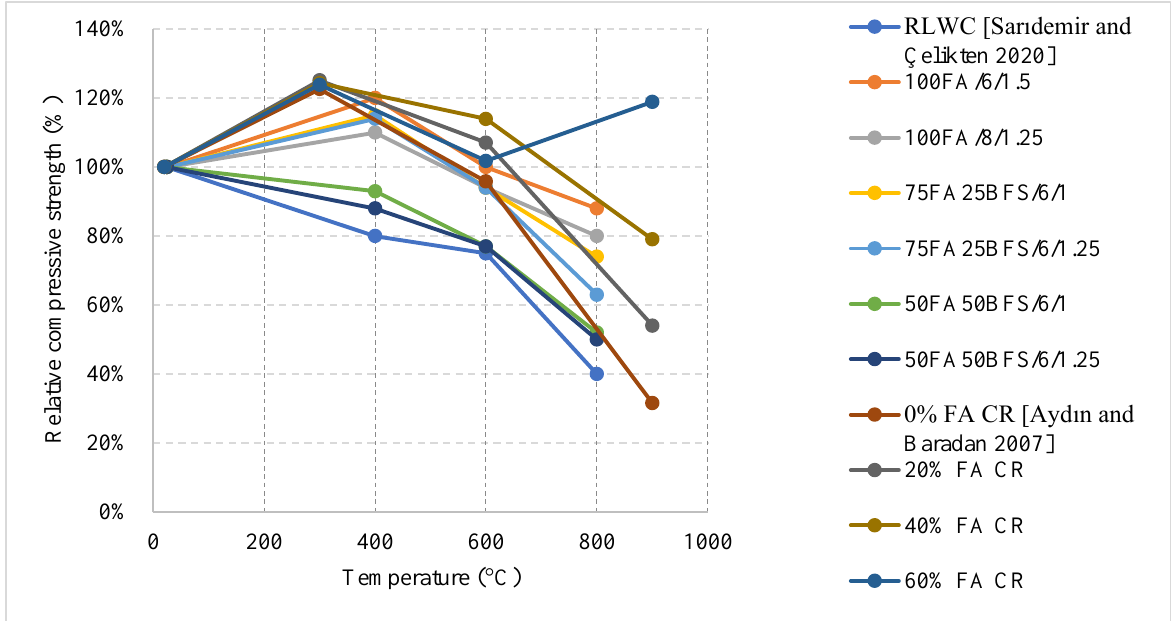
Figure 8. Relative compressive strength of LWC cooled at 0.5 °C/min. R: Reference, FA: Fly Ash, BFS: Basalt Furnace Slag, 100: 100% Cement replacement (CR), 75: 75% CR, 25: 25% CR [61,62].